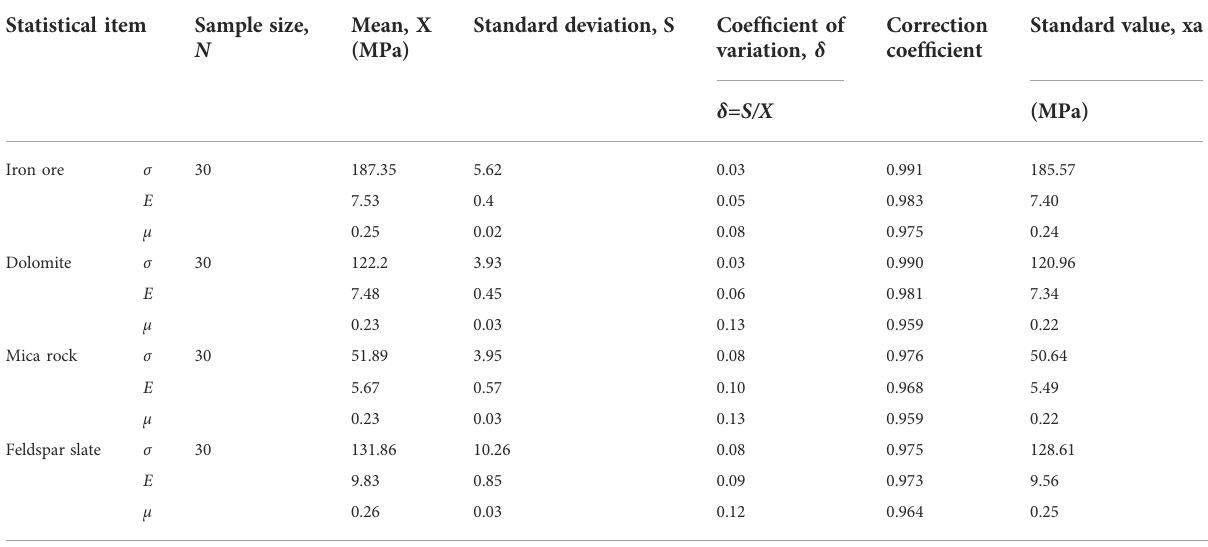
TABLE 2 Test results of compressive strength of mineral rock specimens.